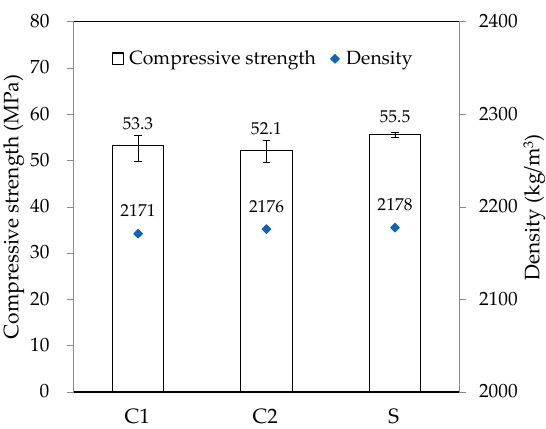
Figure 21. Hardened properties of curved shape underwater printing specimens.